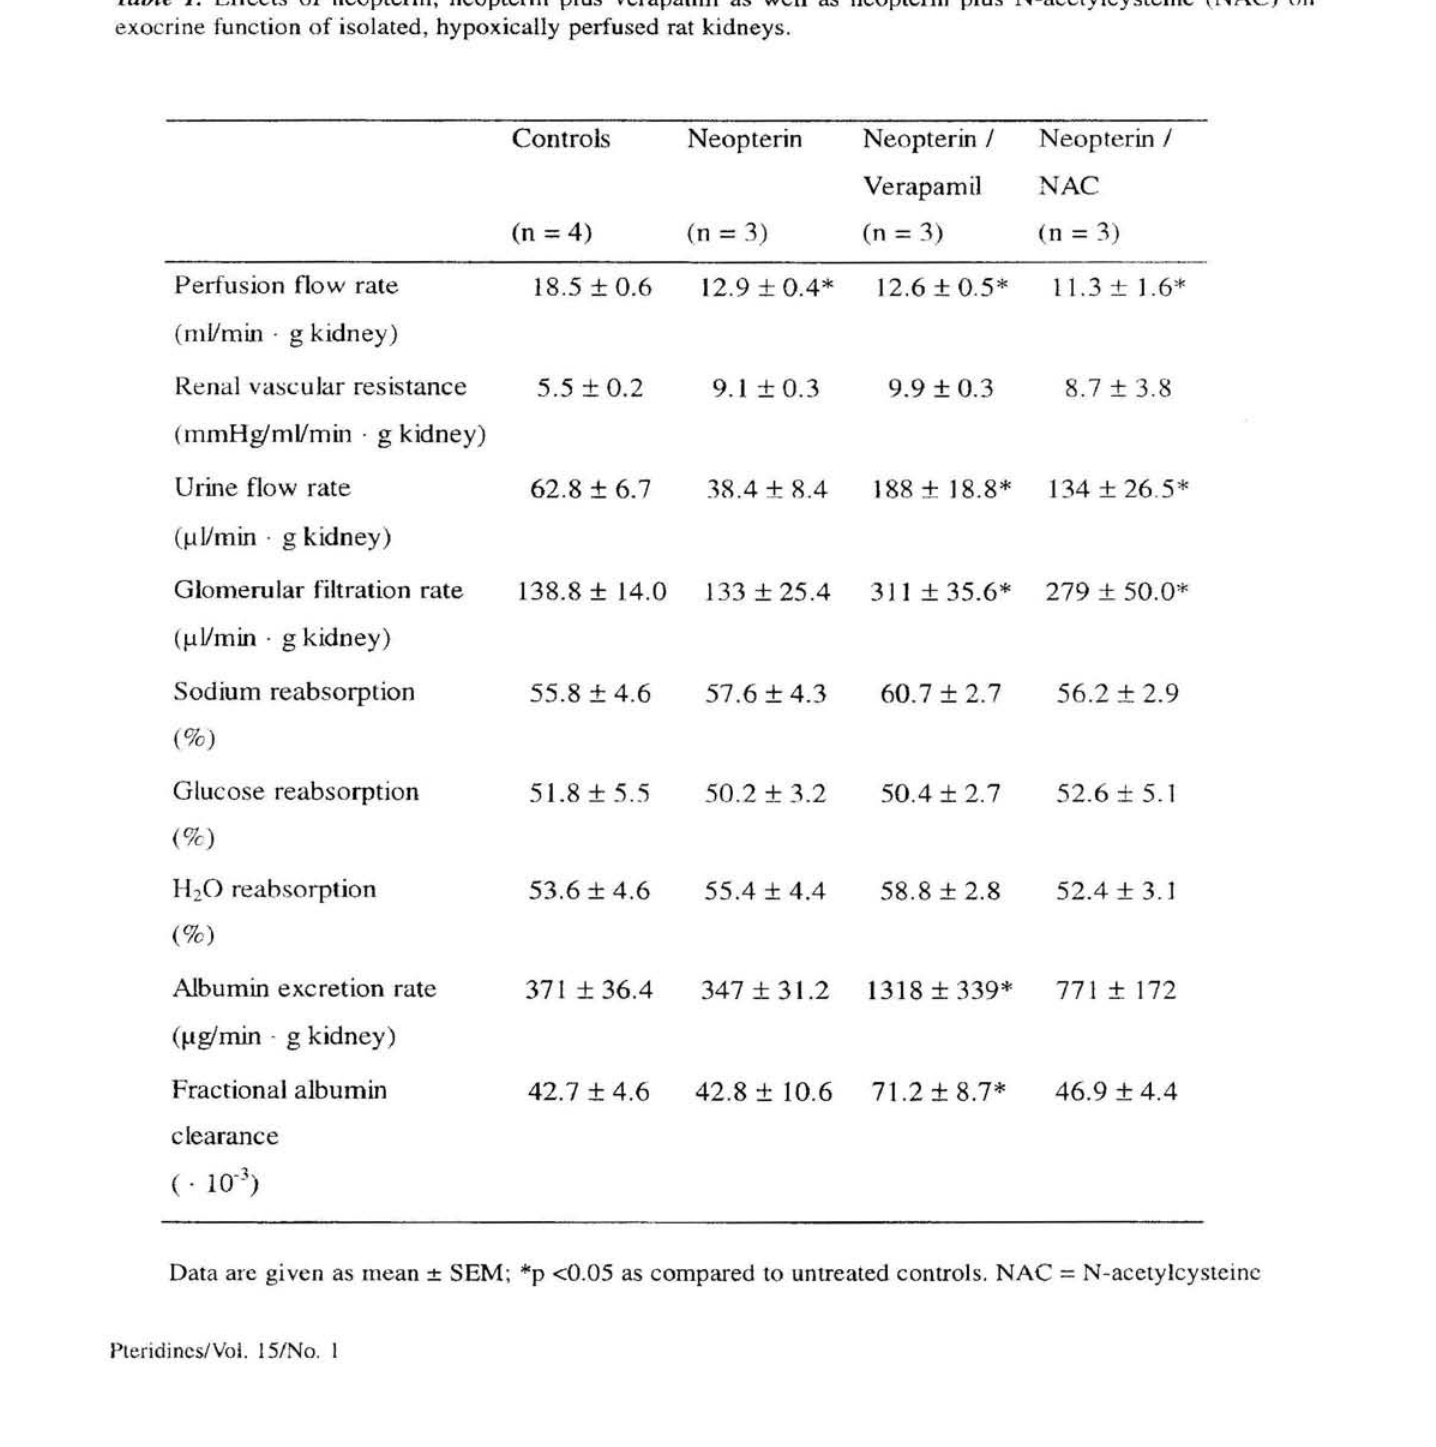
Table 1. Effects of neopterin, neopterin plus Verapamil as well as neopterin plus N-acetylcysteine (NAC) on exocrine function of isolated, hypoxically perfused rat